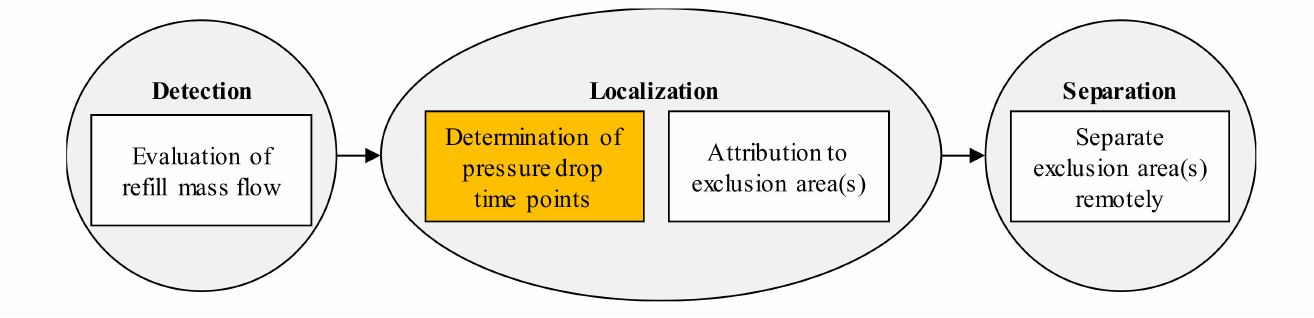
Figure 3. Emergency management steps in the case of a large spontaneous leakage with imminent shutdown of network